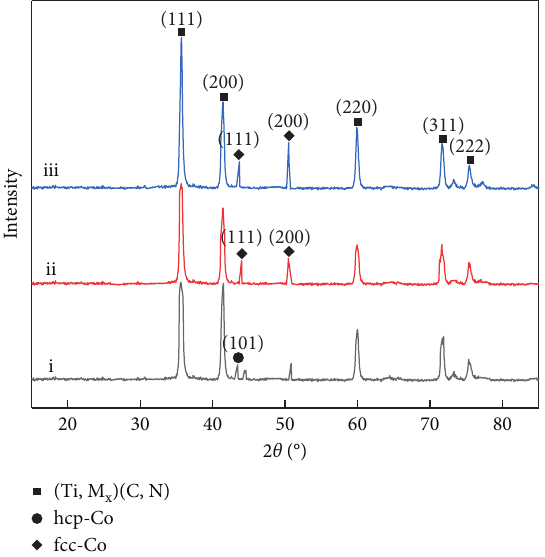
Figure 7: XRD parameters of the structure of the cermet. Table 2: Relative strength of the solid solution phase of cermet samples.